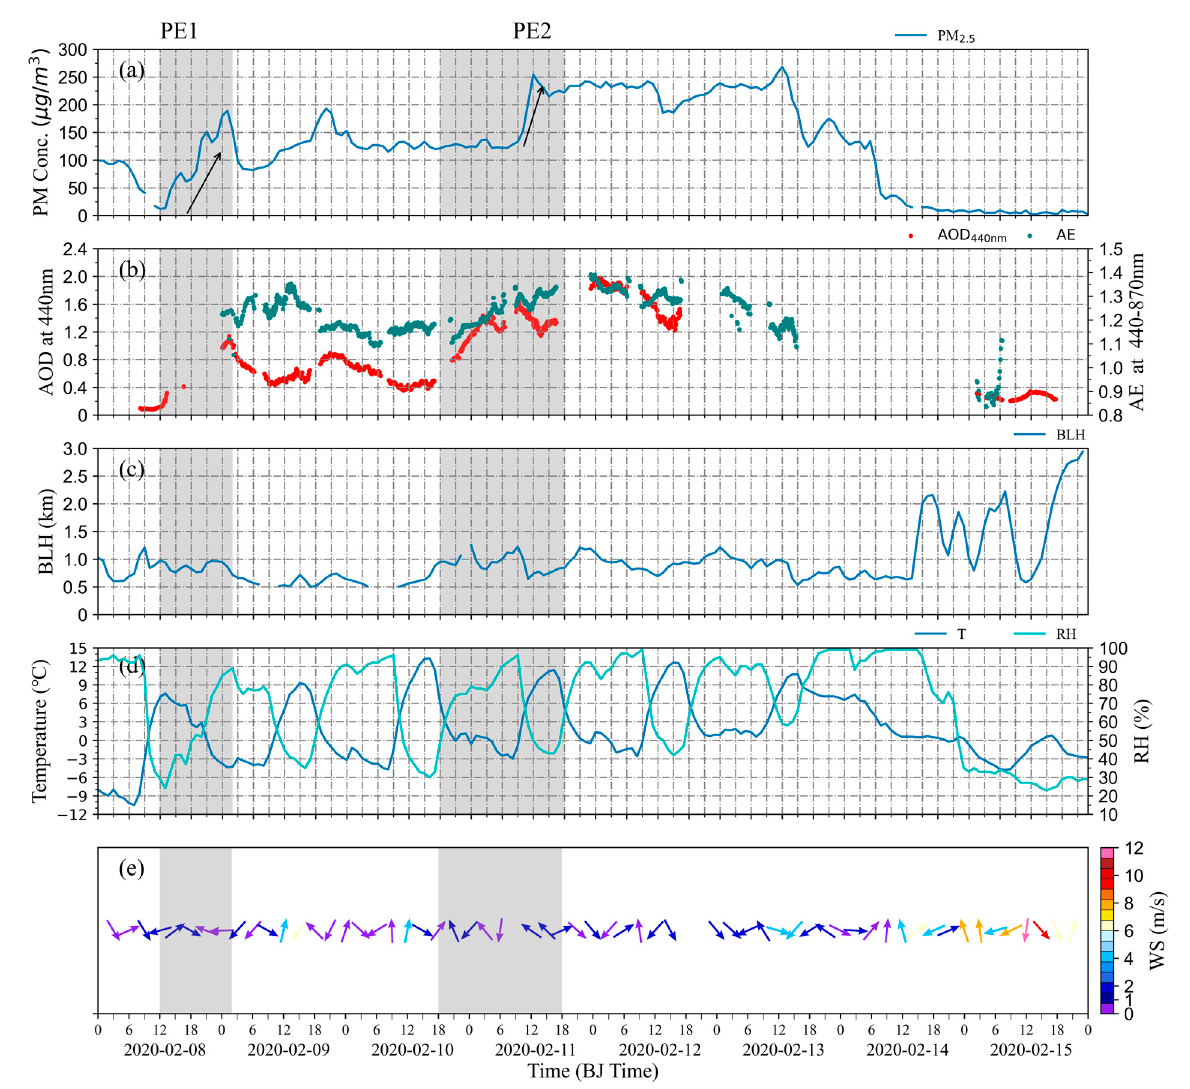
Figure 4. Time series of ( a ) the PM 2.5 mass concentration, ( b ) the aerosol optical depth (AOD) and Ångström exponent (AE 440–870nm ), ( c ) the boundary layer height (BLH), ( d ) the temperature (T) and relative humidity (RH) and ( e ) the wind direction (WD) and wind speed (WS). The arrows indicate explosive increase in PM mass concentration.